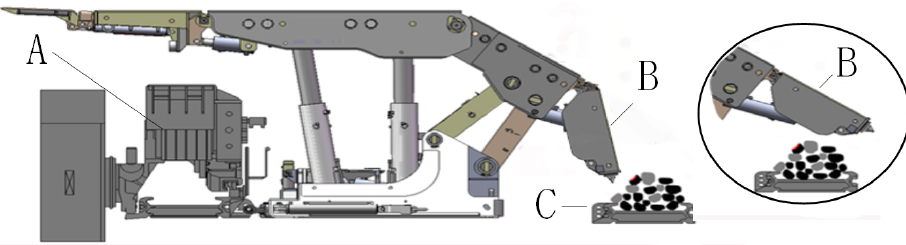
Figure 1. Top-coal caving process. A: Shearer, B: Tail boom of a hydraulic support, it acts as a window open and close. C: Drag conveyor. When the window is opened, the top-coal will collapse and be captured by the drag conveyor. In the sub-graph, the window is closed to prevent the rock falling